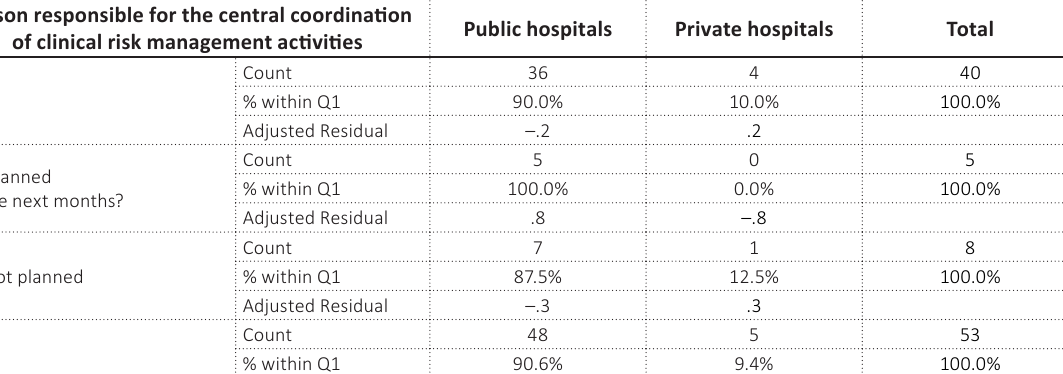
Table 3. Existence of persons responsible for coordinating clinical risk management activities in public and private